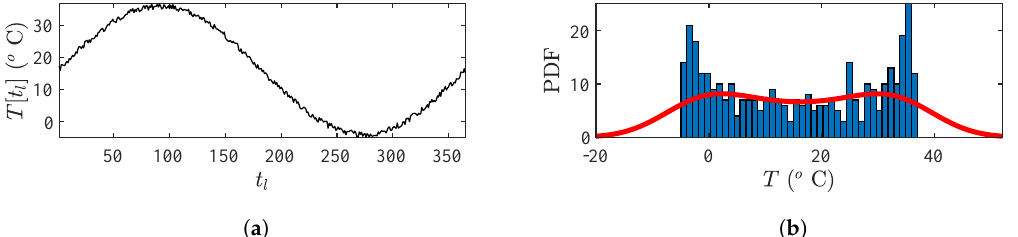
Figure 3. Spring-mass-damper: a realization of the temperature stochastic process: ( a ) Time-series. ( b ) Sample (blue bars) and associated kernel-based (continuous red line) PDF estimates.